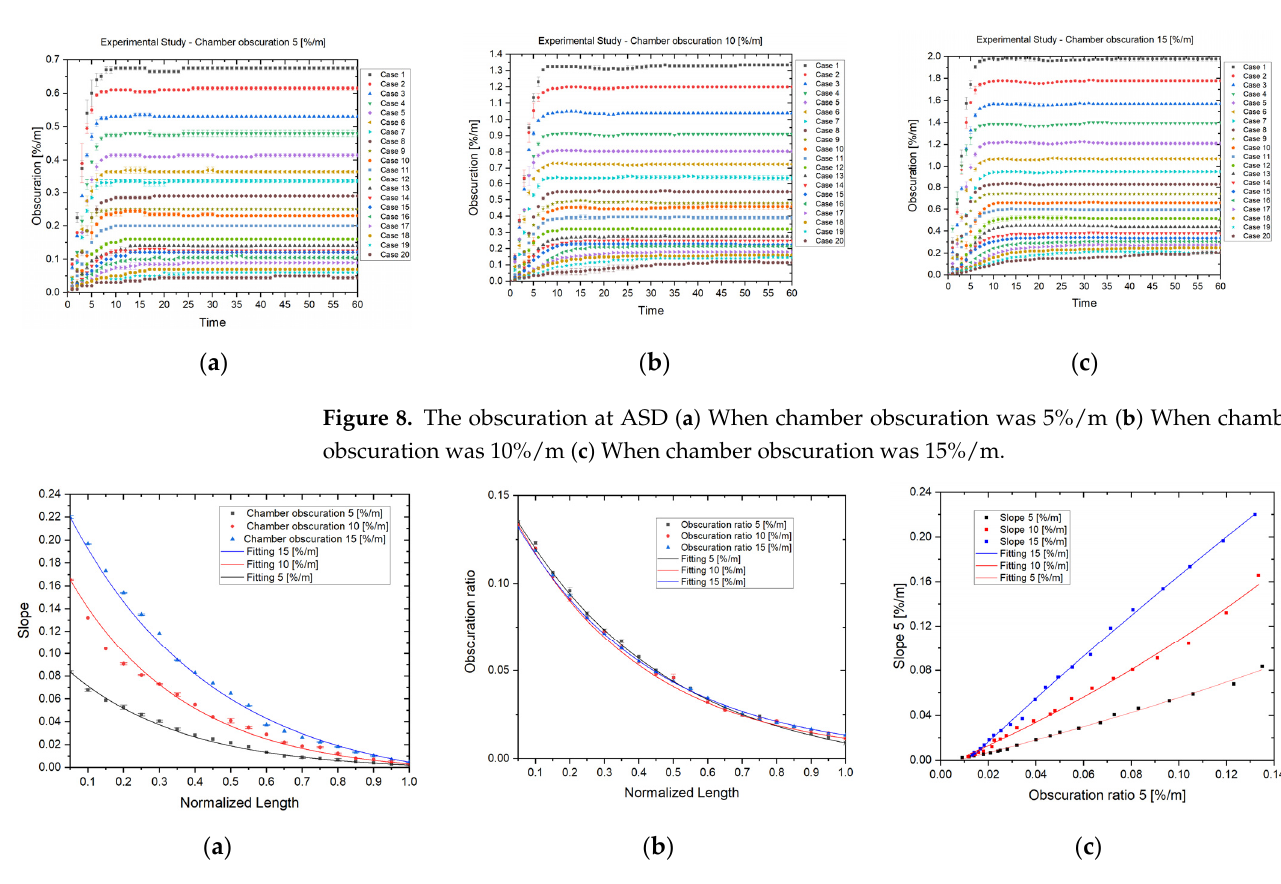
Figure 9. ( a ) The slope and normalized length correlation; ( b ) the obscuration ratio and normalized length correlation; ( c ) the slope and obscuration ratio correlation.